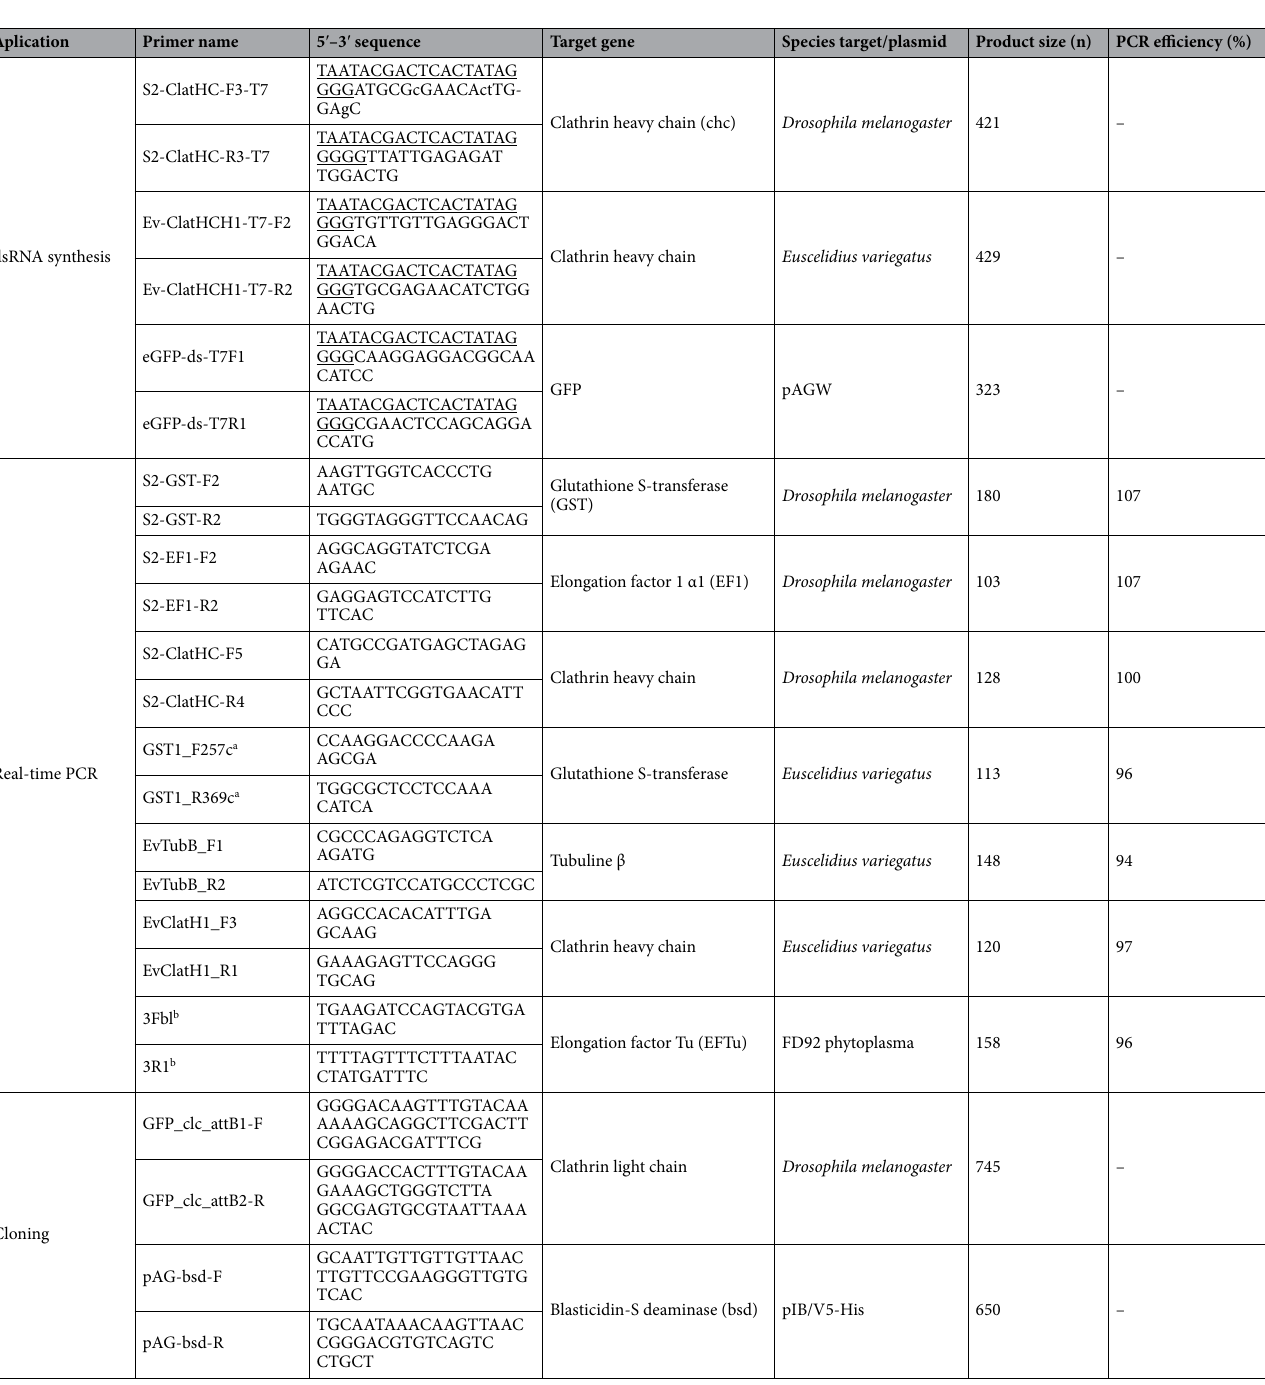
Table 3. Sequence of primers used in this study. T7 promoter sequence is underlined. a Primers were described in Galetto et al. (Galetto, L., Abbà, S., Rossi, M., Vallino, M., Pesando, M., Arricau-Bouvery, N., et al. (2018) Infect Immun 86: e00042–18). b Primers were described in Eveillard et al. (Eveillard, S., Jollard, C.,